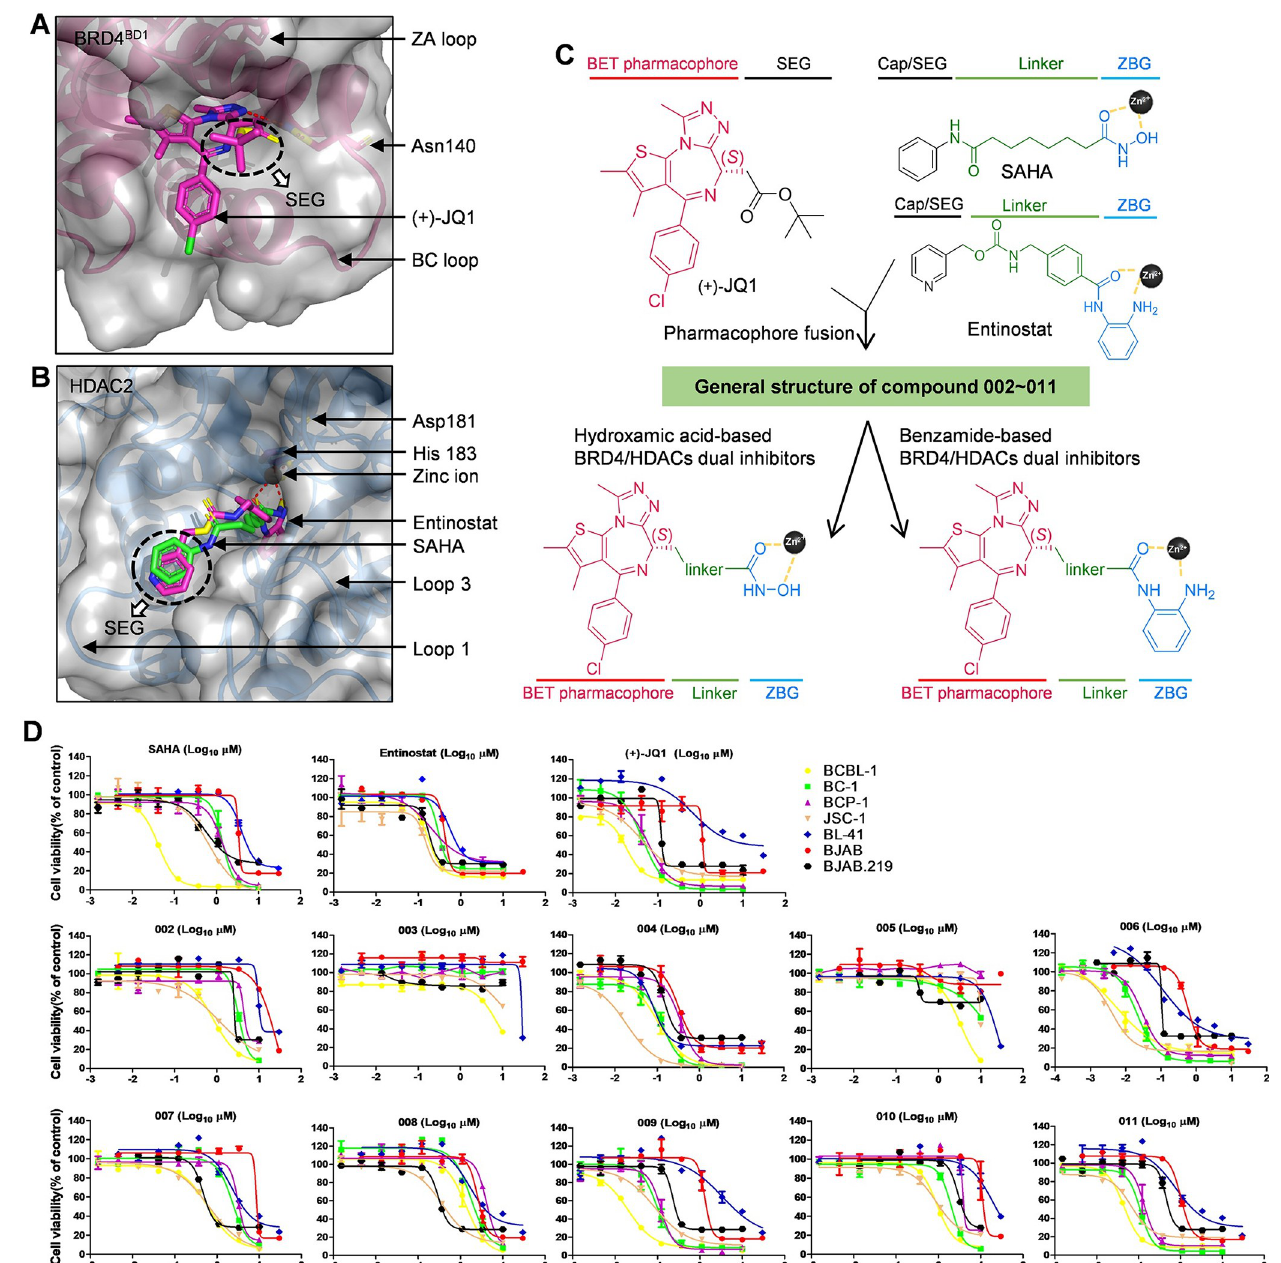
Fig 2. Identification of newly synthesized dual inhibitors with anti-PEL activities. ( A ) The binding mode of (+)-JQ1 with BRD4 BD1 (PDB: 3MXF). BRD4 BD1 is shown as hot pink cartoon with gray surface. Asn140 in BRD4 BD1 is shown as sticks and colored in following pattern: atom C hot pink, atom N dark blue, and atom O yellow. (+)-JQ1 is shown as sticks and colored in following patten: atom C hot pink, atom N dark blue, atom O yellow, atom S golden, and atom Cl green. The solvent exposed region (SEG) of (+)-JQ1 are indicated with white arrow. ( B ) The binding modes of SAHA and entinostat with HDAC2 (PDB: 3MAX). HDAC2 is shown as blue cartoon with gray surface. Asp181 and His183 in HDAC2 are shown as sticks and colored in following pattern: atom C blue, atom N dark blue, and atom O yellow. The catalytic zinc ion in the active site of HDAC2 is shown as black sphere. SAHA is shown as sticks and colored in following pattern: atom C green, atom N dark blue, and atom O yellow. Entinostat is shown as sticks and colored in following pattern: atom C hot pink, atom N dark blue, and atom O yellow. The SEG of SAHA or entinostat is indicated with white arrow. Hydrogen bonds (H-bonds) are presented by red dash lines. ( C ) The HDACs/BRD4 dual inhibitors 002-011 were designed by fusing the key pharmacophores of (+)-JQ1 (pink) and HDAC inhibitors (blue), SAHA or entinostat, via various chemical linkers (green). ( D ) Anti-PEL activities of the new compounds. Five KSHV positive and two KSHV negative lymphoma cell lines were treated with indicated concentrations of these compounds for 72 h. Then the cytotoxicity was determined using the WST-1 assay. (+)-JQ1, SAHA and entinostat were used for the comparisons as single inhibitors. The CC 50 for each compound was calculated using GraphPad Prism 5.0 software. Error bars represent S.D. for 3 independent experiments.